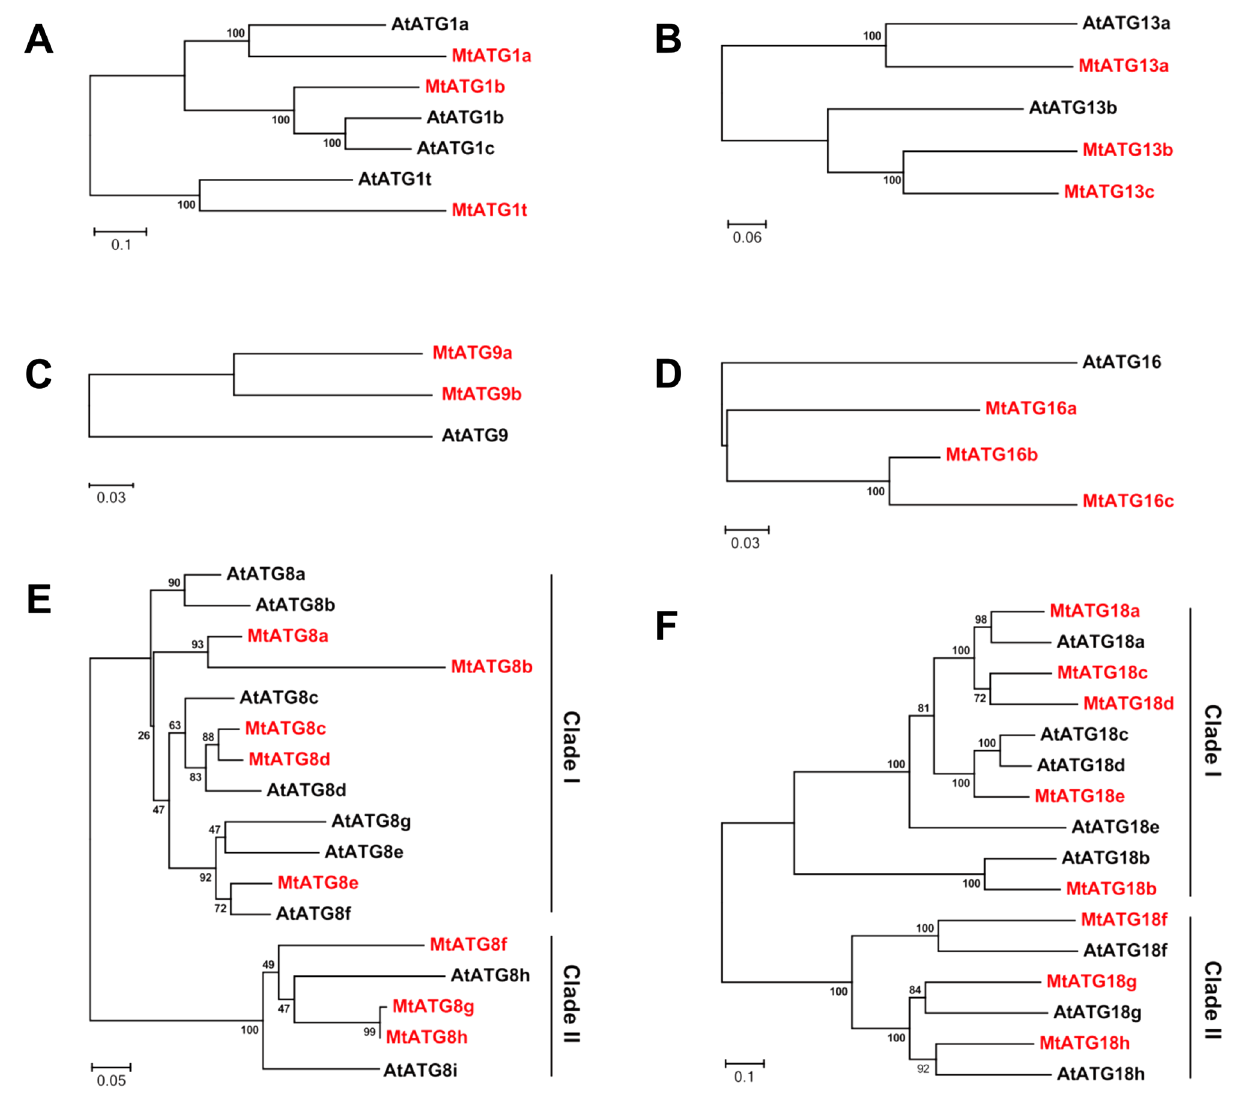
Figure 2. Phylogenetic analysis of ATGs from Medicago truncatula and Arabidopsis thaliana . Phylogenetic tree of ATG1 ( A ), ATG13 ( B ), ATG9 ( C ), ATG16 ( D ), ATG8 ( E ), and ATG18 ( F ) families in M. truncatula and Arabidopsis . The unrooted tree was constructed using MEGA7 based on the multiple sequence alignment of the ATG protein sequences by the neighbor-joining (NJ) method. The number at each node represents the bootstrap value from 1000